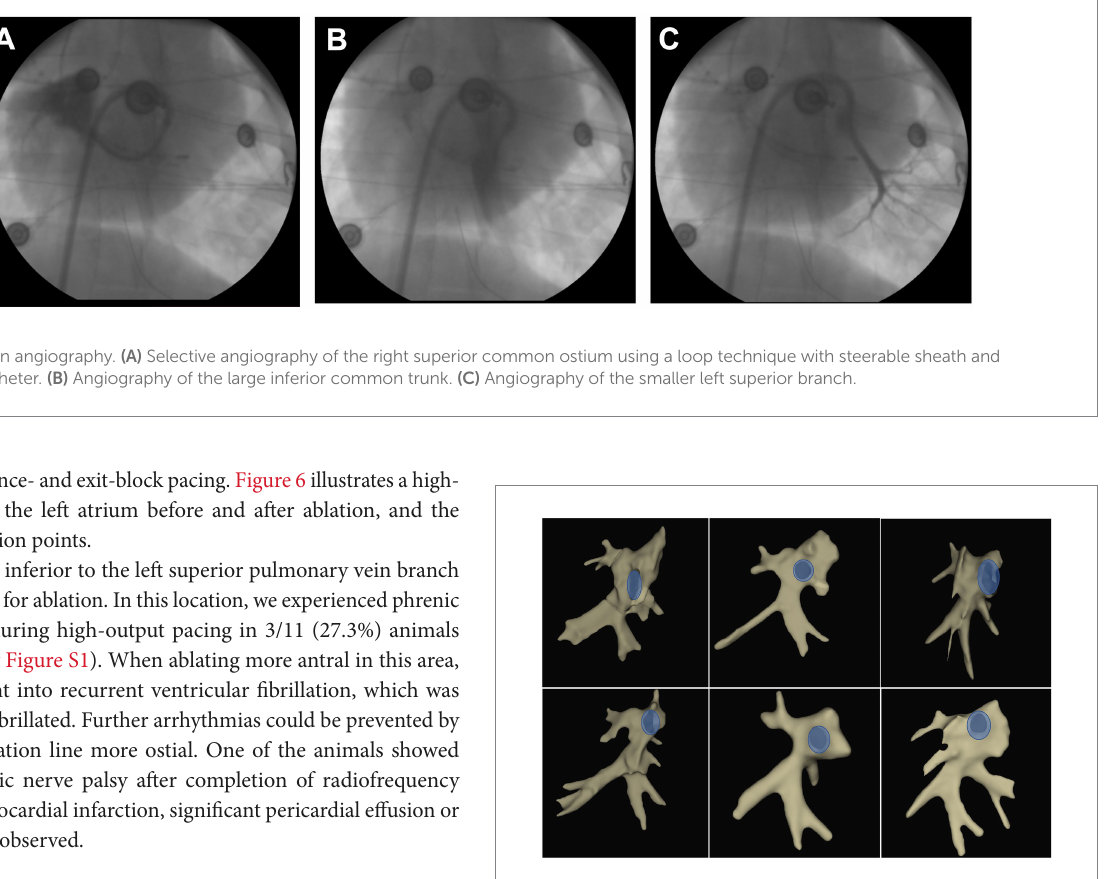
FIGURE 5 Pulmonary vein anatomy. All 3D-electroanatomic images are display in anterior–posterior projection facing the mitral valve (blue). All animals showed a common inferior trunk with a variable number of proximal branches, right middle and right superior branches arising from separate or one common ostium and a variable number of left middle and superior